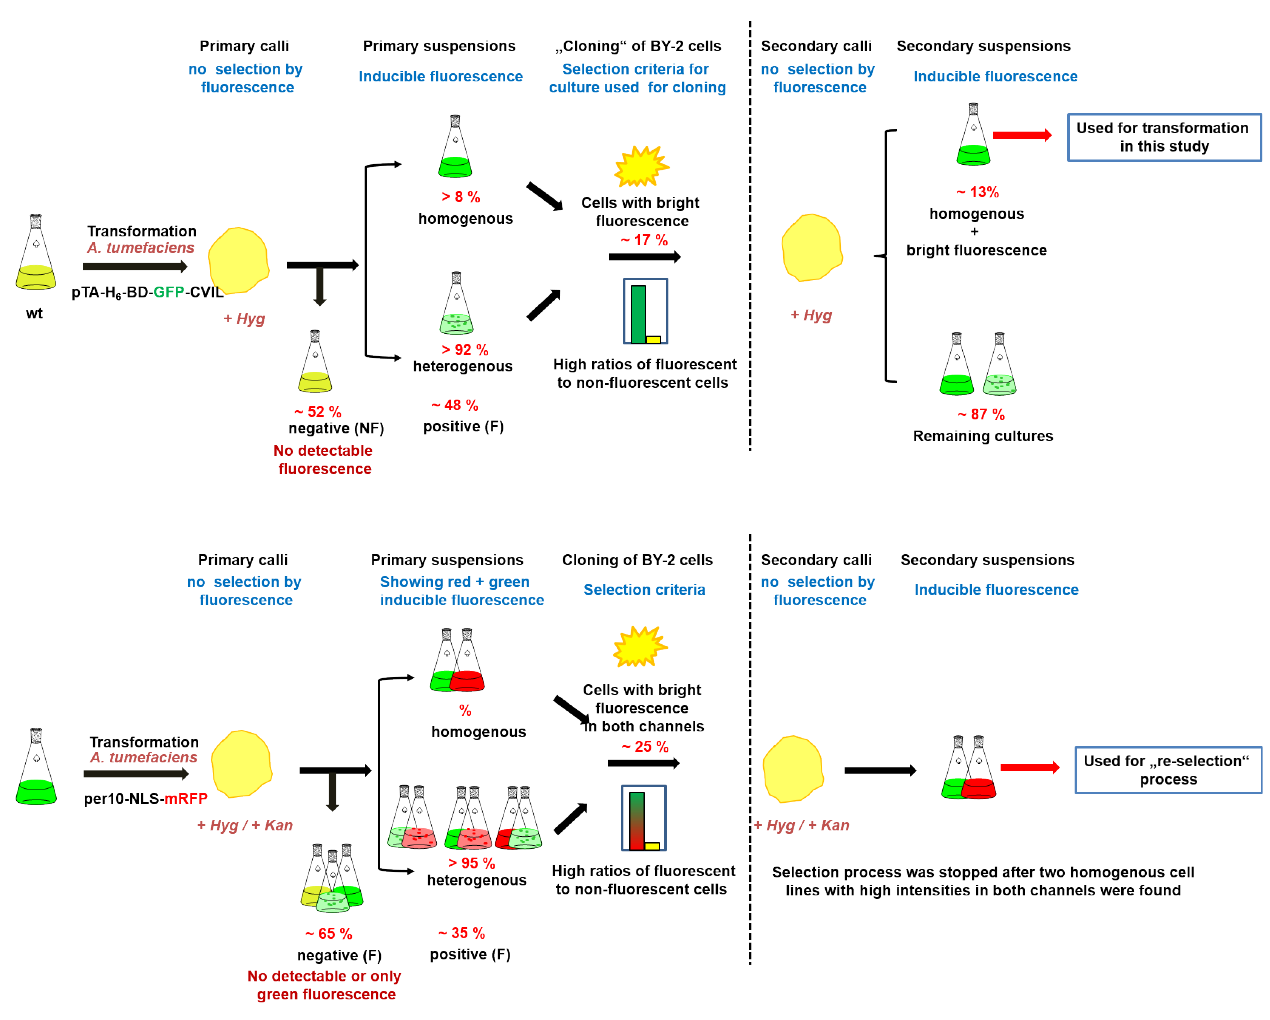
Figure S1. Scheme of the cloning procedure used for the selection of homogenous, transgenic tobacco BY-2 cell lines. A – Selection of �� -GFP-DB-CVIL cell line. B – Selection of the double-transformed �� -GFP-DB-CVIL/NLS-mRFP cell line. The selection of primary and 6 6 secondary calli was performed on antibiotica-supplemented solid plates. As the expression of both fluorescent reporter proteins was inducible, no pre-selection by fluorescence microscopy could be used to eliminate non-fluorescent calli (it was tried by incubation of the calli in presence of the inducers, but no fluorescence could be detected with this method). The selection criteria for cultures used in the cloning procedure were based on the properties optimal for the bioassay (homogenous, bright fluorescence and high ratios of fluorescent to non- fluorescent cells). Rounded values for statistical evaluation are indicated if available.